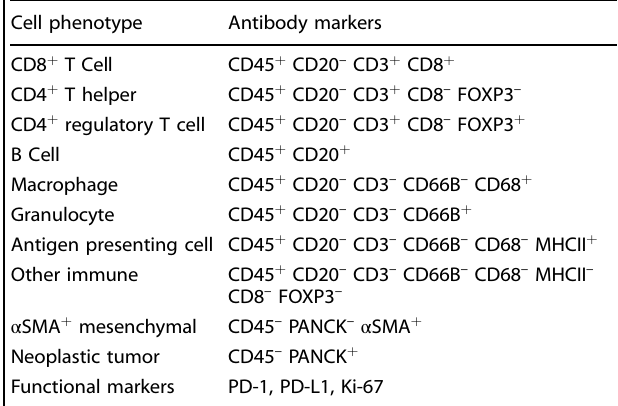
Table 2. mIHC cell phenotype classi fi cation.